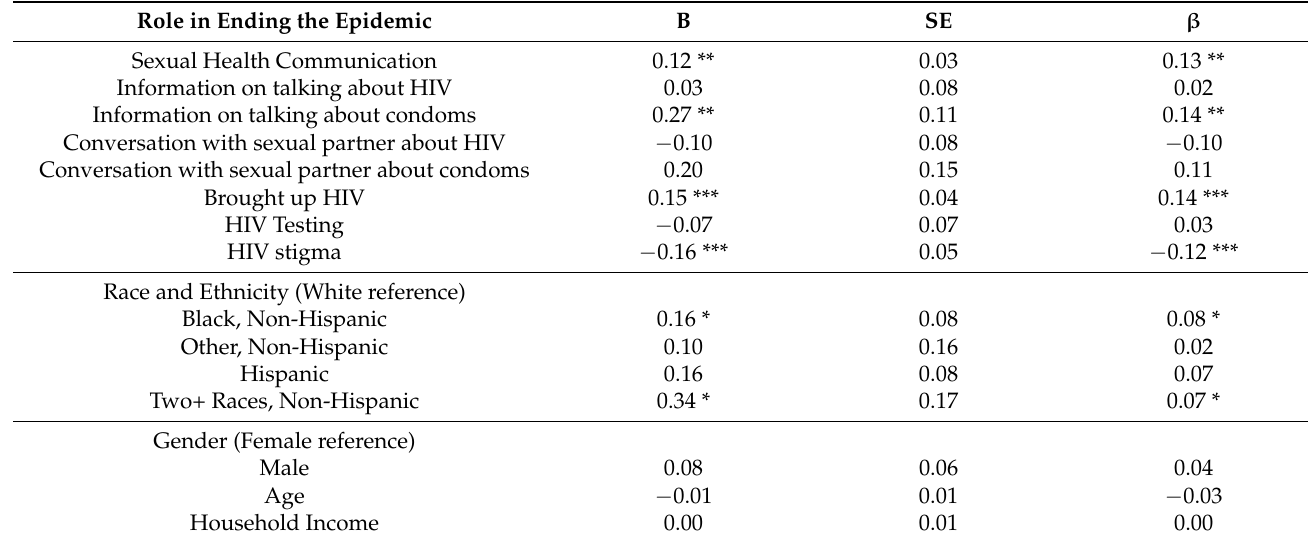
Table 4. Multivariate Analysis among sexually active youth and young adults on role in ending the epidemic ( n = 701). Role in Ending the